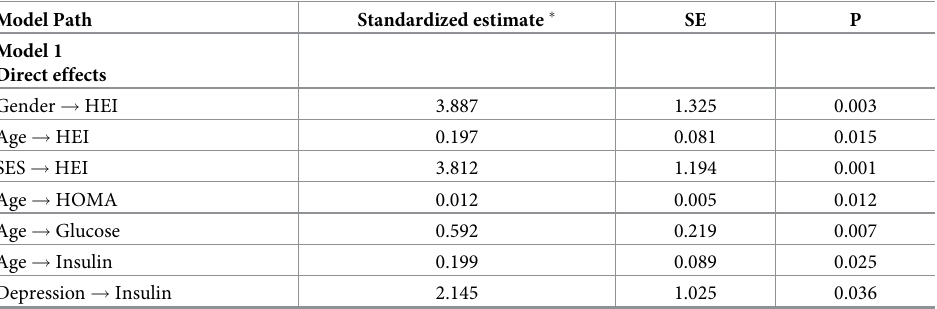
Table 4. Statistically significant direct and indirect pathways of the association between socio-demographic and psychological variables and insulin resistance indices and cardio-metabolic risk factors among obese individuals using